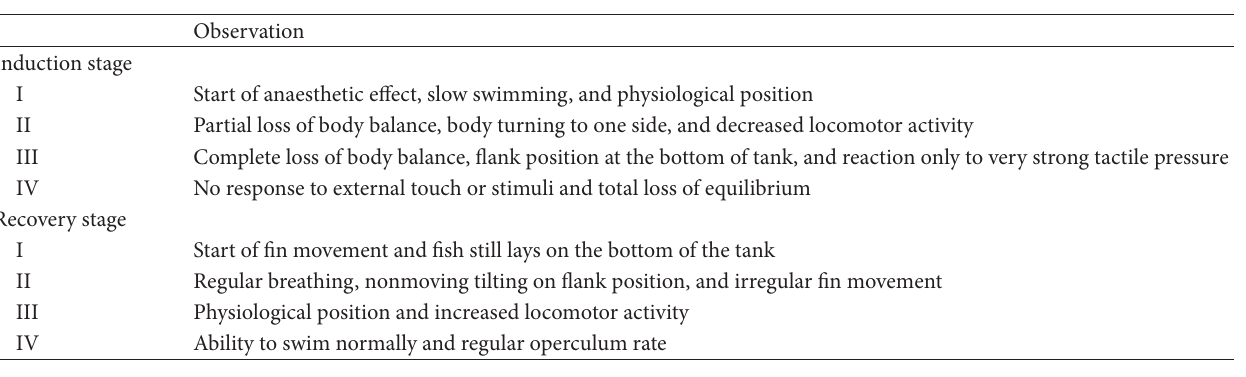
Table 1: Stages of anaesthesia used to determine the efficacy of 2-phenoxyethanol for Sahyadria denisonii (modified from Marking and